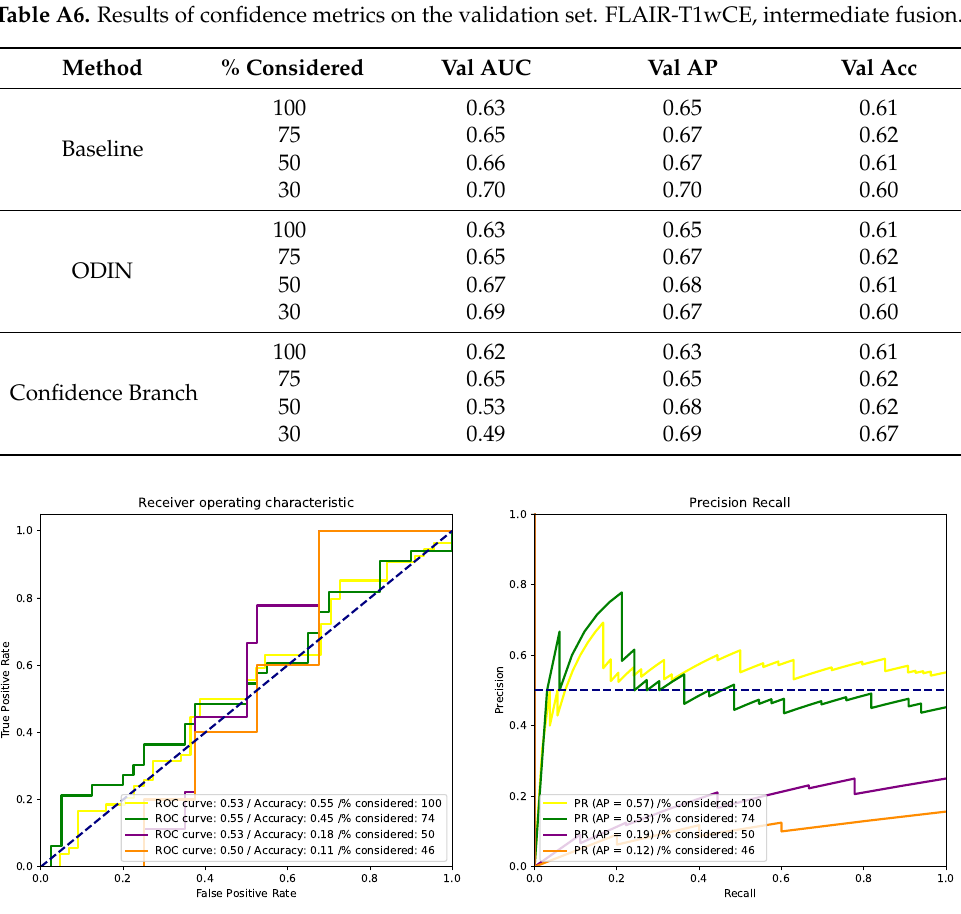
Figure A8. ROC and PR curves for the methylation percentage metric. FLAIR-T1wCE, intermediate